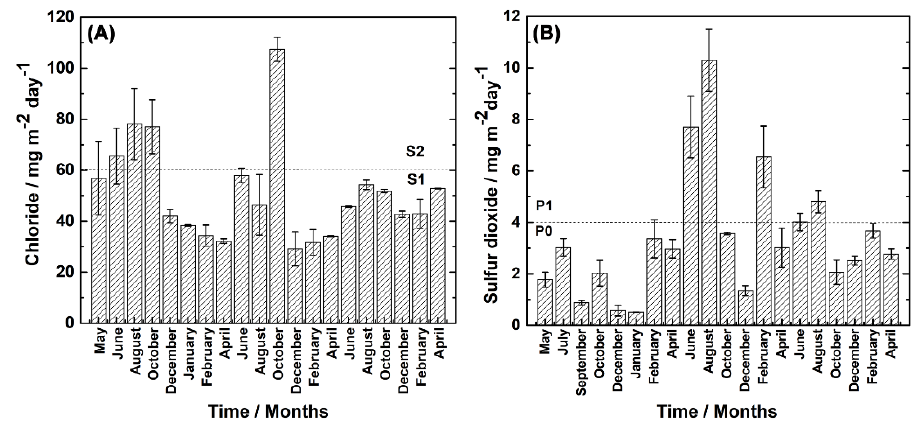
Figure 4. Environmental chloride ( A ) and sulfur dioxide ( B ) contents in the study period. Table 1. Environmental Corrosivity Category